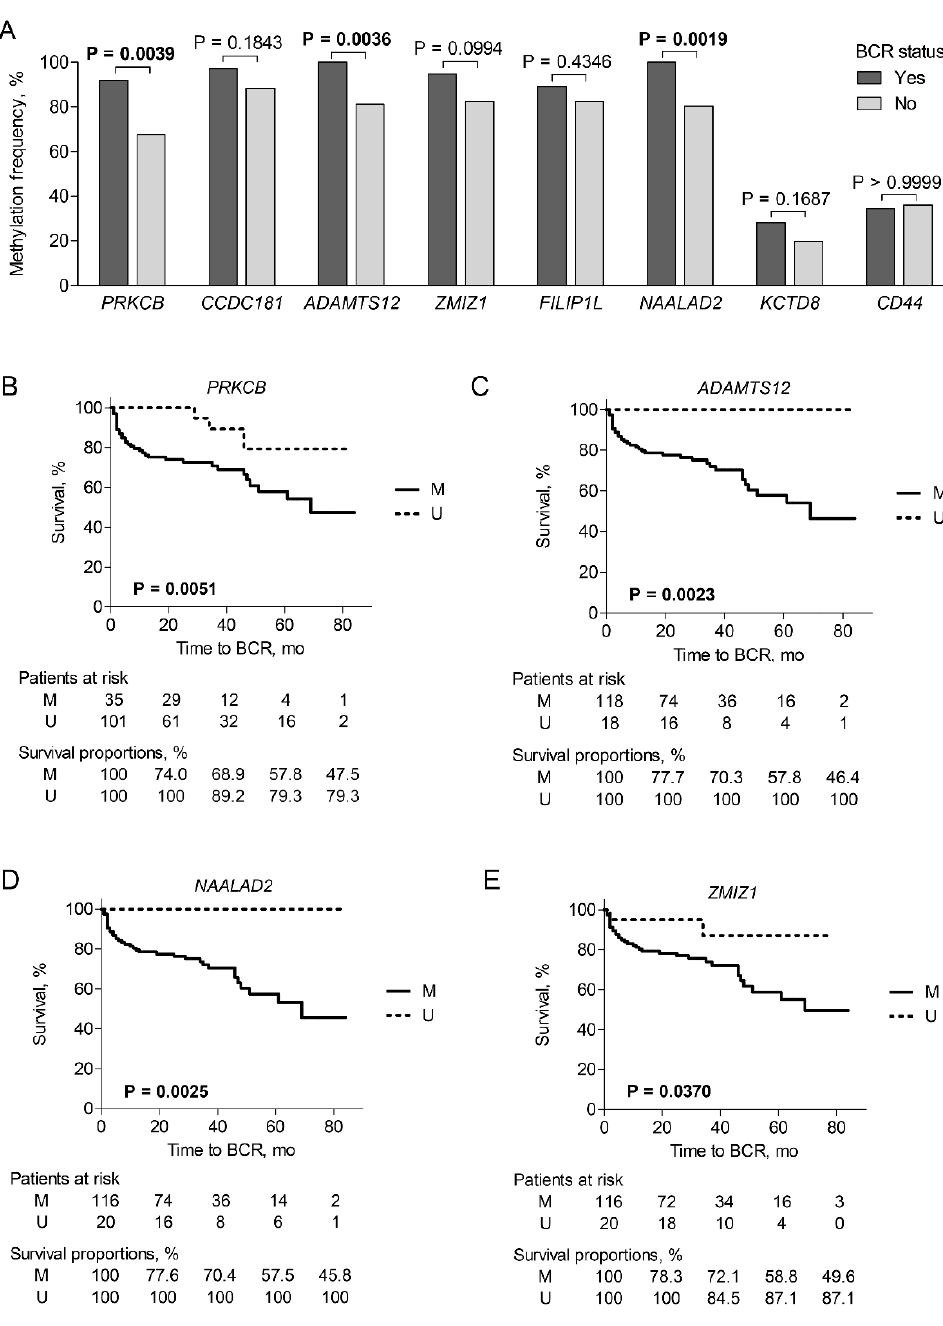
Figure 4. Promoter methylation status of selected genes in prostate cancer (PCa) according to biochemical recurrence (BCR) status. ( A ) Promoter methylation frequencies of the analyzed genes; ( B – E ) Kaplan-Meier curves according to meth- ylation of ADAMTS12 , NAALAD2 , PRKCB, and ZMIZ1 . M—methylated, U—unmethylated. Significant p -values are marked in